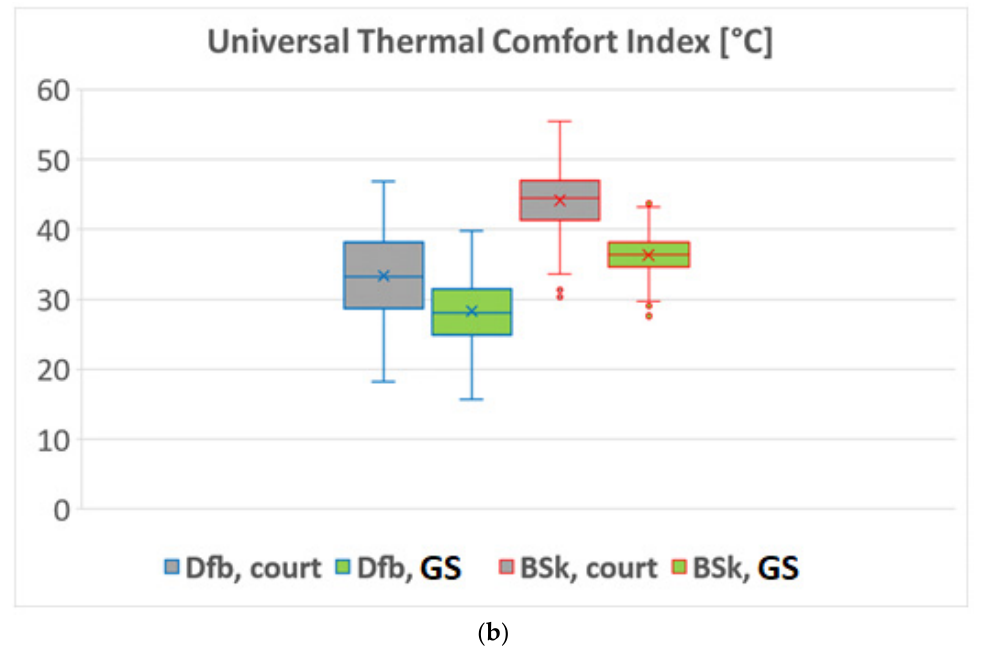
Figure 9. The reduction of ( a ) T mrt and ( b ) UTCI by the GS application in the courtyard. Results of the simulation for two cities: Poznan, Poland–Dfb acc. To Köppen and Murcia, Spain–BSk acc. To Köppen. Analyzed period: July and August (typical meteorological year) between 10:00 and 18:00.